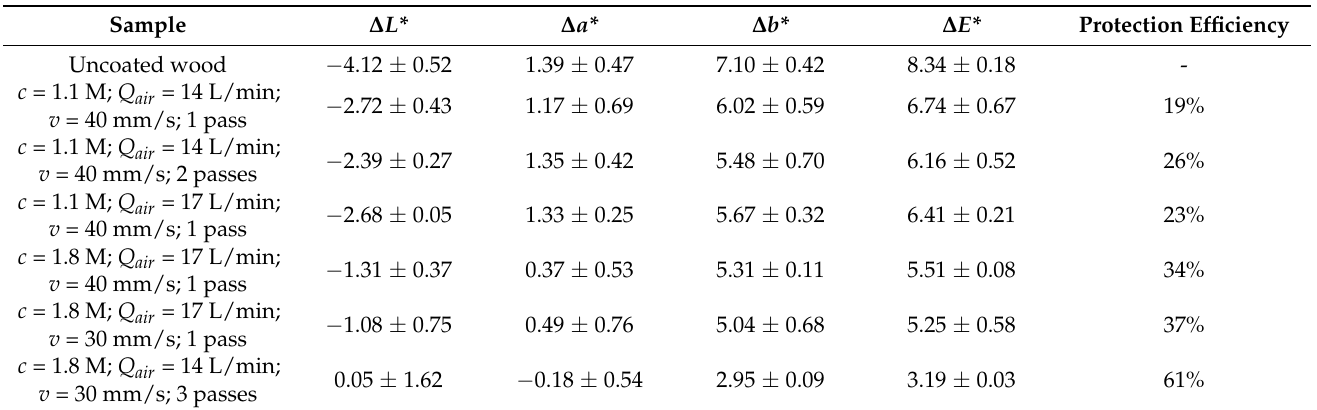
Table 3. Differences in color measurements before and after 170 h exposure to UV